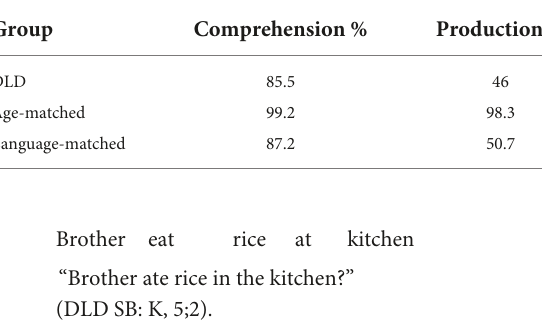
TABLE 4 Comprehension and production overall performance across the three